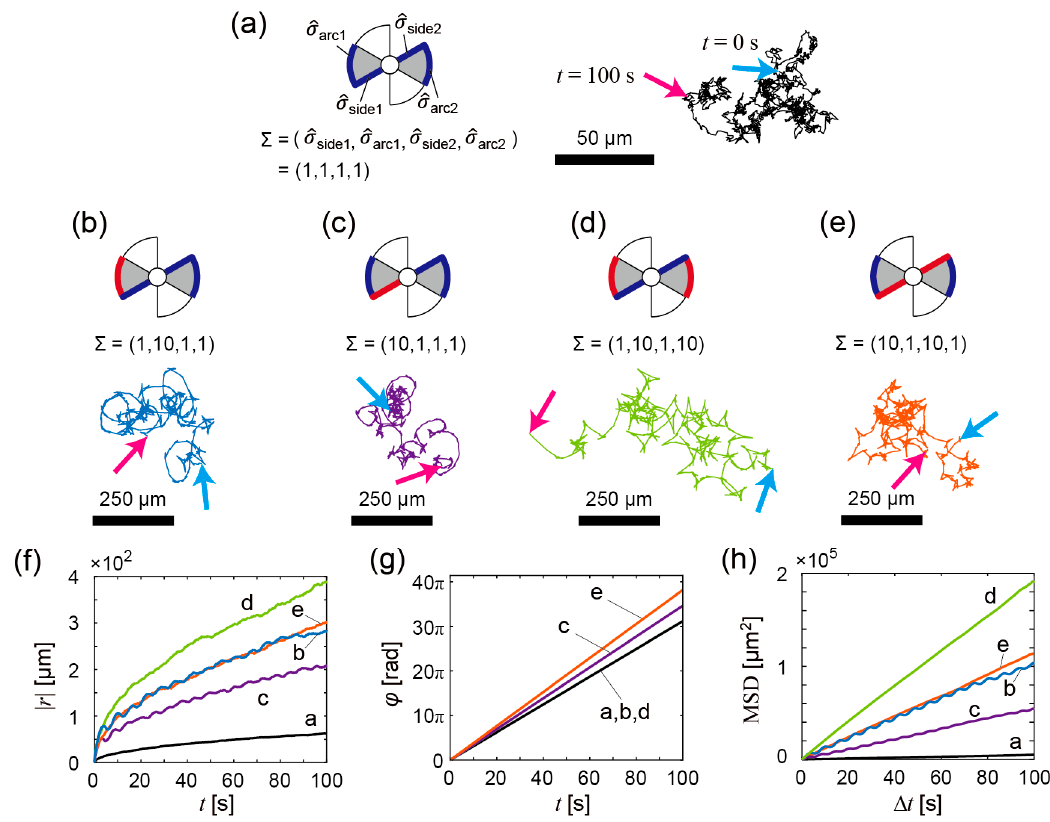
Figure 5. Numerical analyses of bubble propulsion of the propeller-shaped micromotors with double catalytic sites. ( a – e ) Calculated trajectories of the micromotor in each condition of Σ = ( σ(cid:3549) side1 , σ(cid:3549) arc1 , σ(cid:3549) side2 , σ(cid:3549) arc2 ). Red lines/curves: the sides and the arcs that generate a pushing force with large fluctuation. Blue lines/curves: the sides and the arcs that generate a pushing force with small fluctuation. Σ = (1, 1, 1, 1) (symmetric) ( a ); Σ = (1, 10, 1, 1) (asymmetric) ( b ); Σ = (10, 1, 1, 1) (asymmetric) ( c ); Σ = (1, 10, 1, 10) (symmetric) ( d ); Σ = (10, 1, 10, 1) (symmetric) ( e ); Cyan arrow: t = 0 s; magenta arrow: t = 100 s; ( f ) The time variation of | r ( t )|. Black line: For trajectory of ( a ); blue line: For trajectory of ( b ); purple line: For trajectory of ( c ); green line: For trajectory of ( d ); orange line: For trajectory of ( e ); ( g ) The time variation of ϕ ( t ) . The notation of each line is same as ( f ); ( h ) The time variation of mean square displacement (MSD) G MSD ( t ) . The notation of each line is same as ( f